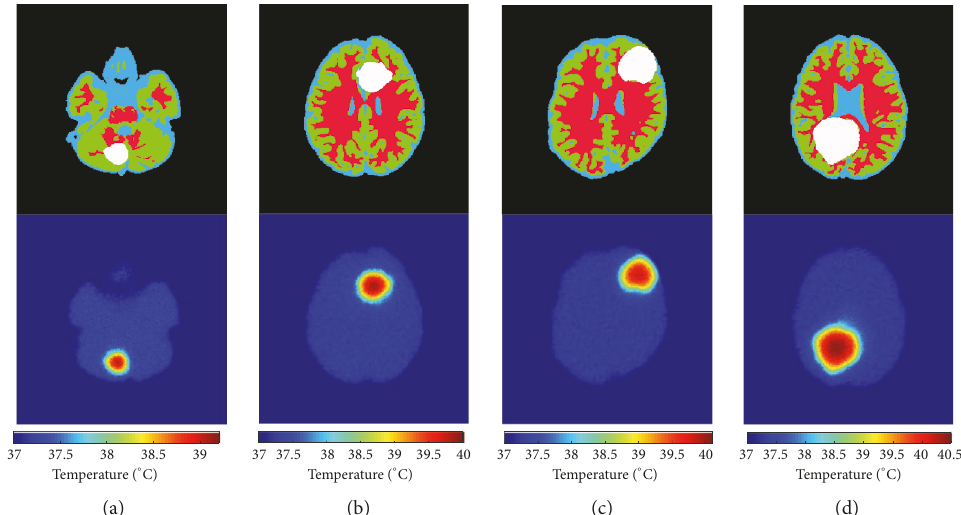
Figure 4: Temperature distribution with noise of brains with realistic tumors of different volumes. (a) Tumor with 11.6 cm 3 of volume. (b) Tumor with 27.4 cm 3 of volume. (c) Tumor with 51.1 cm 3 of volume. (d) Tumor with 81.7 cm 3 of volume.